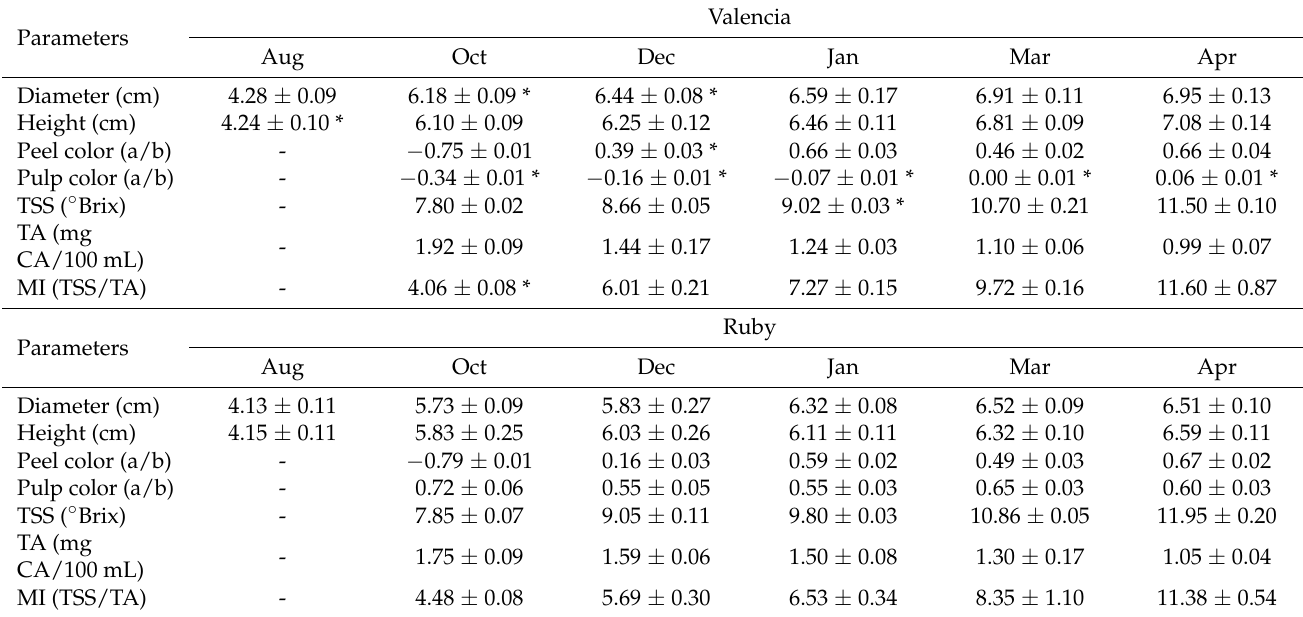
Table 2. Changes in fruit diameter and height, peel and pulp color, and internal-quality parameters of Valencia and the red-fleshed Ruby oranges during development and